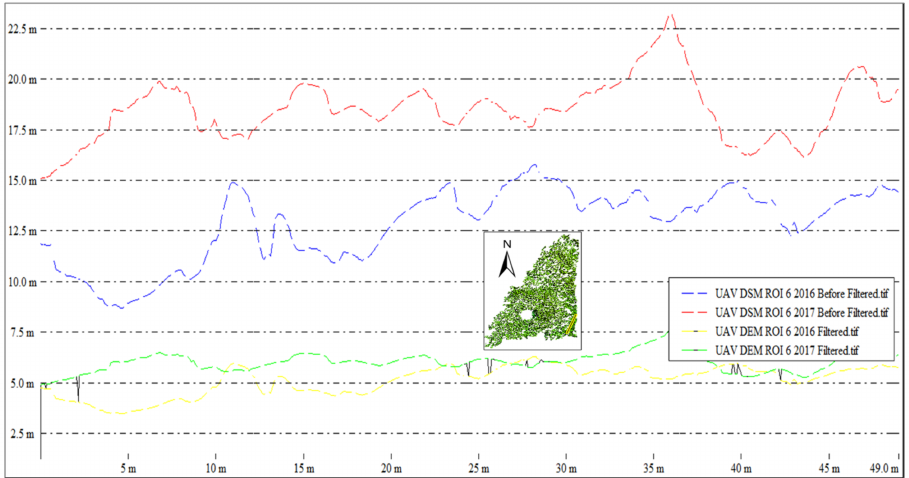
Figure A12. Average height comparison between filtered and unfiltered for ROI